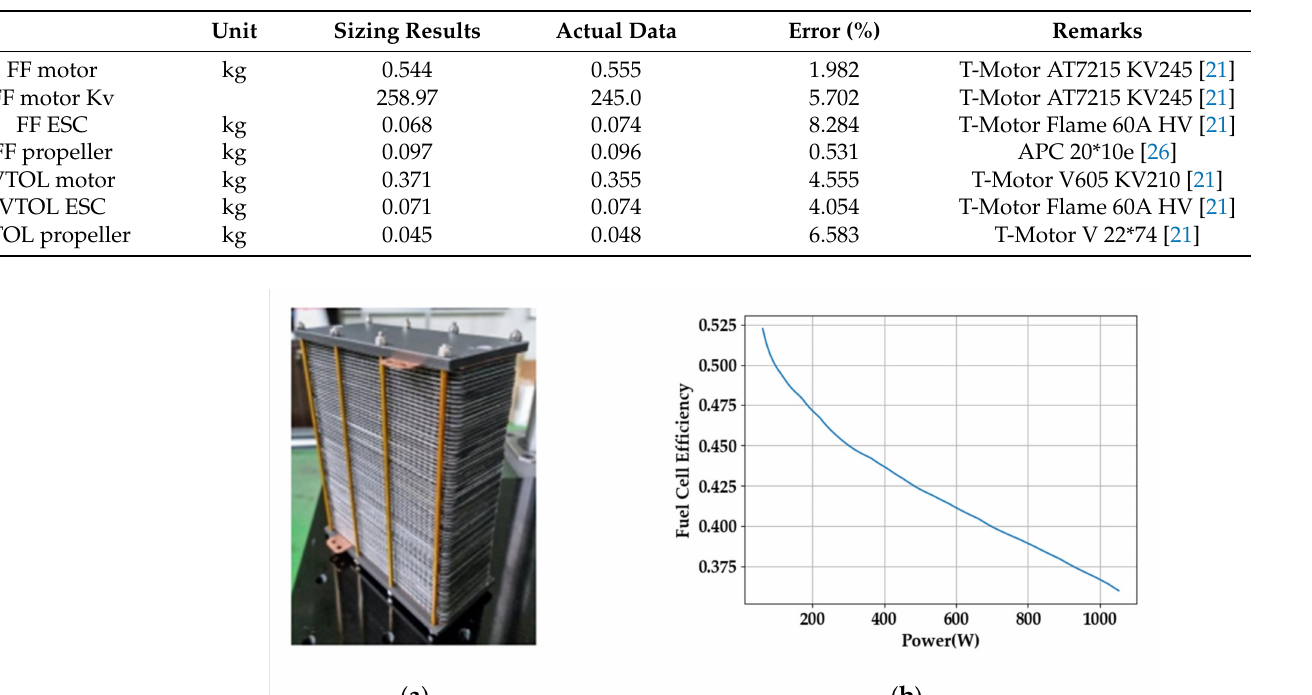
Table 10. Comparison of motor, ESC, propeller sizing results, and actual data.